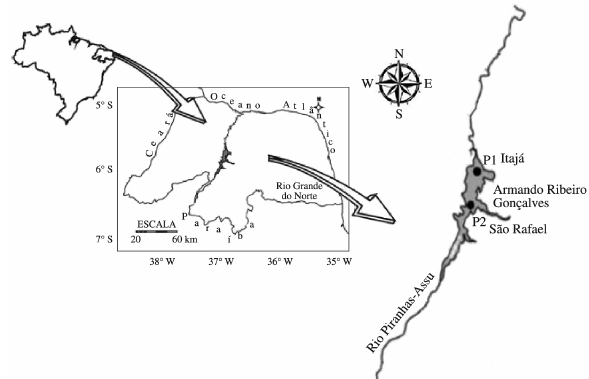
Figure 1. Geographical location of Armando Ribeiro Gonçalves Reservoir, Northeast Brazil (P1: Itajá and P2: São